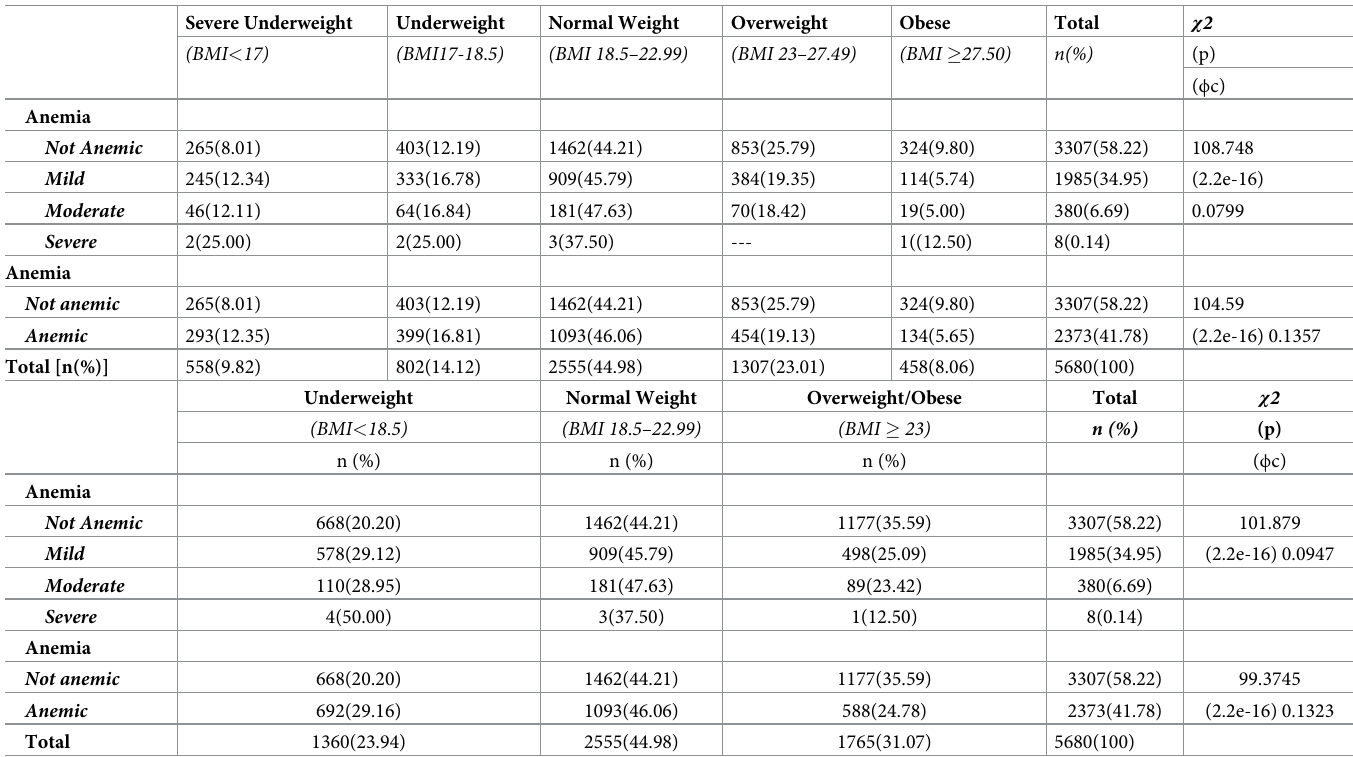
Table 1. Prevalence of anemia among women (n = 5680) based on BMI category. Severe